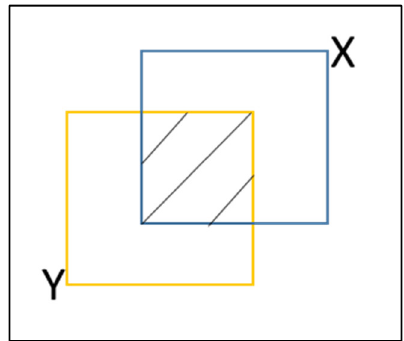
Figure 1. Graphical depiction of co-registration error. The global positioning system (GPS) ( Y ) and Image ( X ) sample units represent the same extents located on surface of the earth, but due to co-registration errors they only share a portion of the same area in projected space (diagonal black lines).